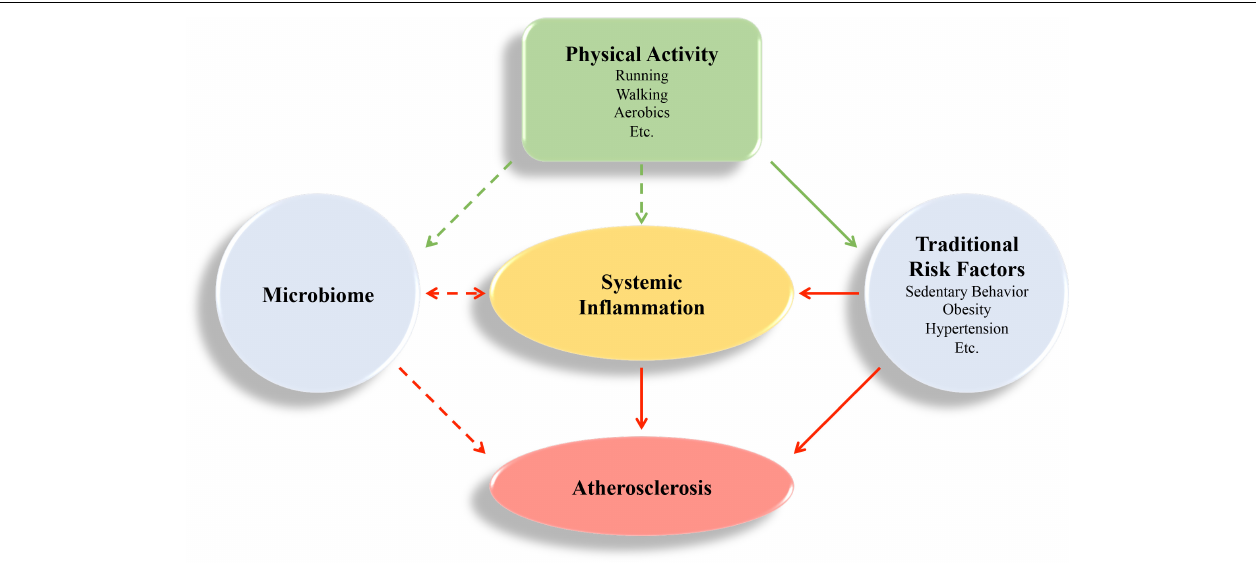
FIGURE 1 | Visual Summary. Atherosclerosis is an inflammatory disease that is regulated by systemic inflammation. Physical activity can have beneficial effects (green arrows) by regulating systemic inflammation directly, and through behavioral and environmental factors that cause inflammation, like sedentary behavior, obesity, hypertension, and the microbiome. These risk factors contribute to deleterious effects (red arrows) and promote atherosclerosis development. The impact of the microbiome on atherogenesis is an emerging field, and the mechanism of how physical activity regulates the microbiome is not completely understood. Inflammation may also regulate the microbiome (van den Elsen et al., 2017; Chen et al.,